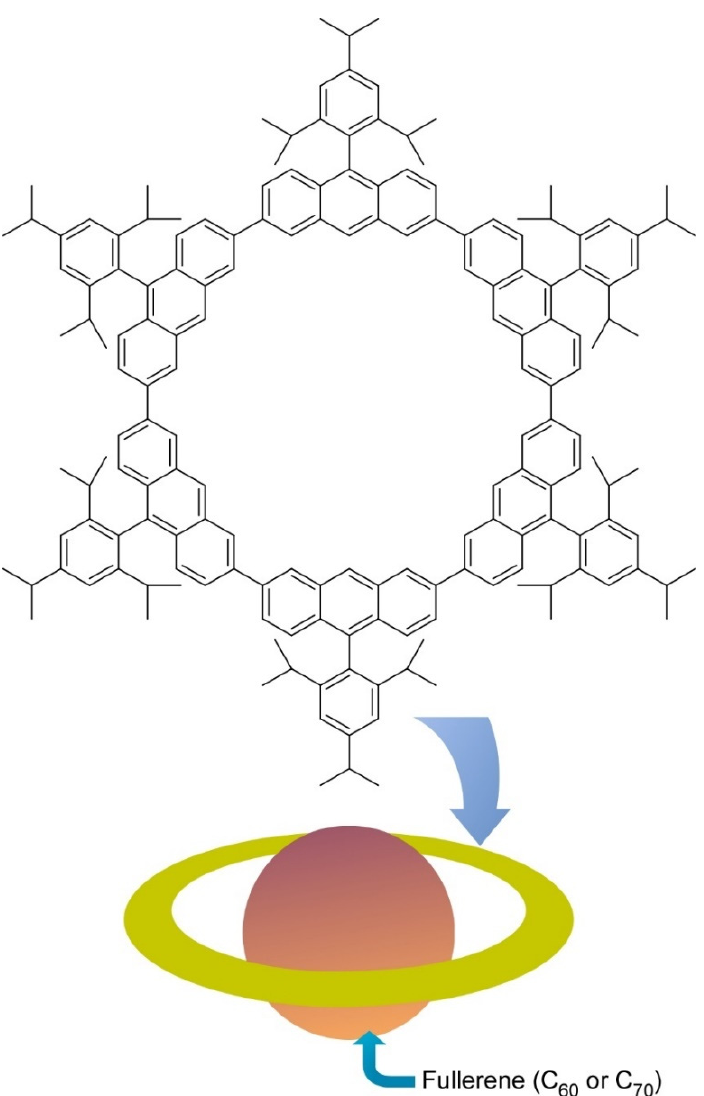
Figure 5. Nano-Saturn through supramolecular association between anthracene macrocyclic ring and ellipsoidal C 70 molecule.